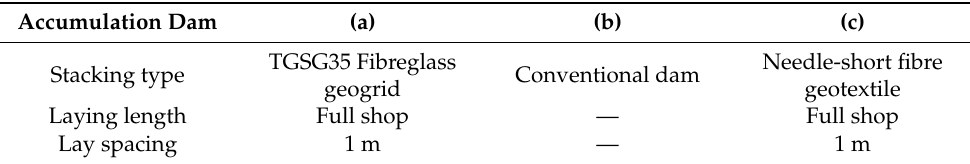
Figure 2. Design of the surrounding tailings accumulation dams. ( a ) Main and side views. ( b ) Top view. Table 1. Stacking type and relevant parameters of surrounding